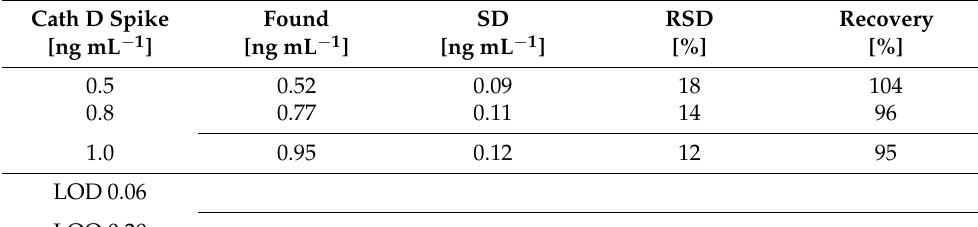
Table 4. Precision and recovery of Cath D determination using the biosensor with a pure gold chip and adhesive foil as a separating